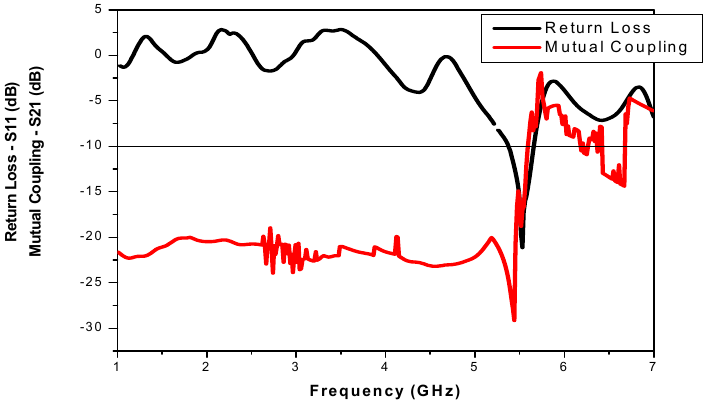
versus frequency of 21